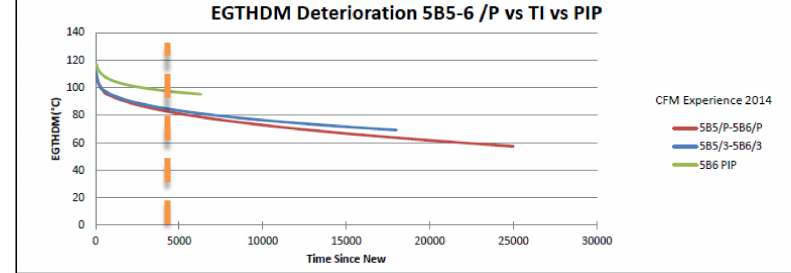
Figure 7. LLP data from the engine removal report relating to the landing.